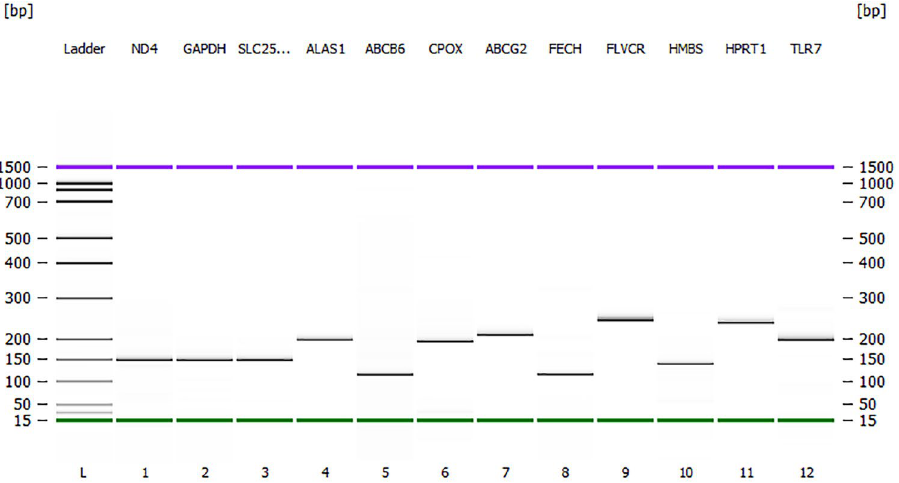
Figure 4. Amplification of the genes fragments from the shell gland tissue of a chicken to assess the specificities of the primers used in the current study. L. DNA marker; (1) ND4 (137 bp); (2) GAPDH (137 bp); (3) SLC25A38 (139 bp); (4) ALAS1 (197 bp); (5) ABCB6 (107 bp); (6) CPOX (187 bp); (7) ABCG2 (208 bp); (8) FECH (112 bp); (9). FLVCR1 (239 bp); (10) HMBS (131 bp); (11) HPRT1 (245 bp); (12) TLR7-positive control (200 bp). The upper (purple) and lower (green) markers act as internal standards and are used to align the ladder analysis with the individual DNA sample analysis. The standard curve (plotting migration time against DNA amplicon size), in conjunction with the markers, is then used to calculate DNA fragment sizes for each well from the migration times measured (see Agilent 2100 Bioanalyzer Users Guide for Molecular Assays). The DNA gel in Agilent 2100 Bioanalyzer was performed as per the manufacturer’s instructions of Agilent DNA 1000 Kit.